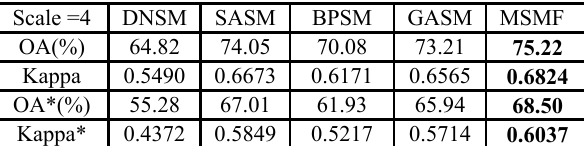
Table 2. Comparison of five sub-pixel mapping algorithm performances for the synthetic Washington D. C. hyperspectral remote sensing imagery